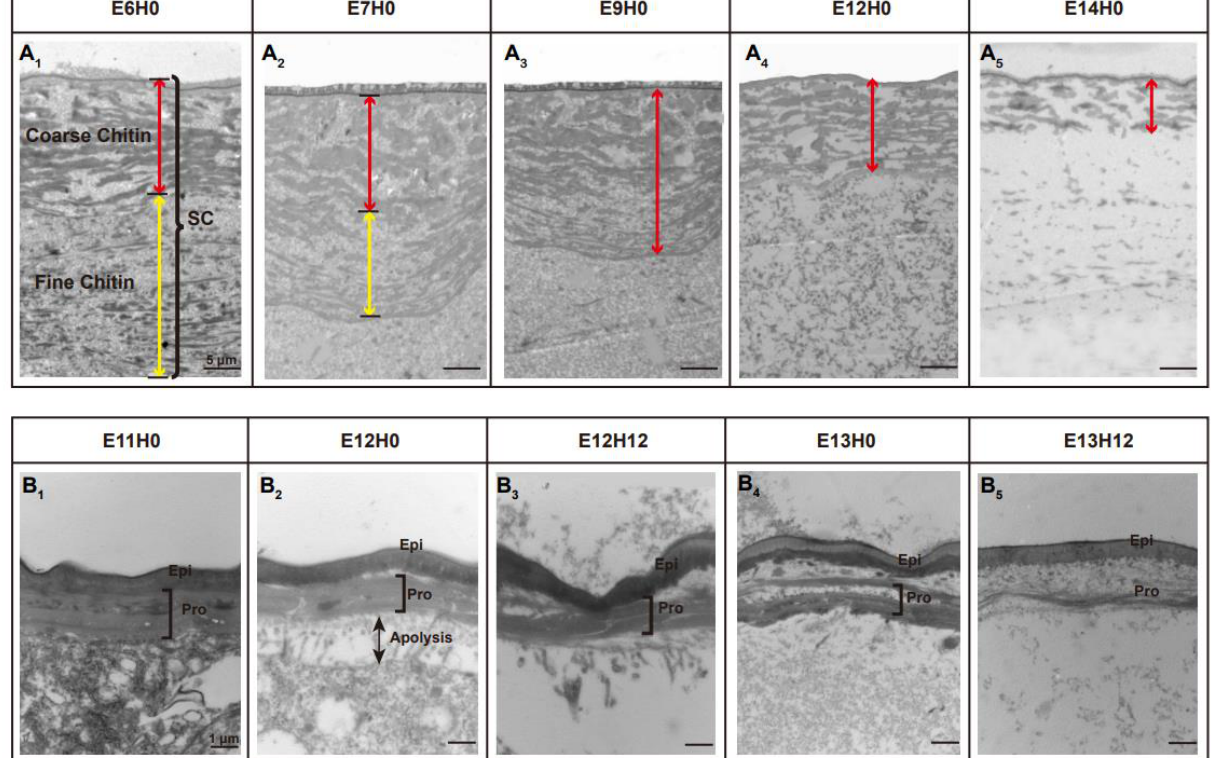
Figure 1. TEM analysis of the ultrastructure of the degradation process of the serosal cuticle and the pro-nymphal cuticle. ( A 1 ): The serosal cuticle is thickest at E6, with the overall stratified structure neatly arranged. The cuticle is composed of a coarse atypical layer on the upper part and a fine atypical layer near the cells on the lower part. ( A 2 ): The serosal cuticle is overall thinner, indicating a degenerated state at E7. The fine parts of the lower layer gradually disappear, while the coarser structures of the upper layer become loose. ( A 3 ): The coarser structure of the serosal cuticle was gradually relaxed at E9. ( A 4 ): The coarser structures on the upper surface continue to degenerate, and the serosal cuticle becomes thinner at E12. ( A 5 ): The coarser structure of the upper layer degenerates into a loose filamentary structure, and the fine chitin structure of the cuticle is almost completely degenerated. Scale bar is 5 µ m. SC: serosal cuticle. The red line shows the coarse layer in the upper part, while the yellow line shows the fine chitin layer in the lower part. ( B 1 ): The pro-nymphal cuticle, which consists of an epicuticle and multi-layer procuticle, shows a thickened state at E11. ( B 2 ): The pro-nymphal cuticle begins to degrade at E12. The small gap between the epicuticles and the procuticles indicates the separation of the epicuticles and the procuticles. At the same time, the procuticle separates from the cell, which is called apolysis. ( B 3 ): The epicuticle and procuticle continue to separate at E13, while the layer structure of the procuticle begins to degrade. ( B 4 ): All layer structures of the procuticle are completely loose at E13H12. ( B 5 ): The procuticle of the pro- nymphal cuticle degenerates completely at E14, leaving only the epicuticle. Scale bar is 1 µ m. Epi: Epicuticle; Pro: